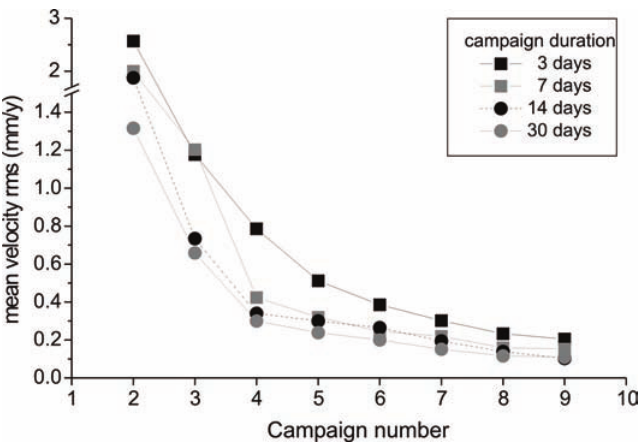
Figure 3. Mean rms of the velocity differences for the east and north components based on the campaign numbers.